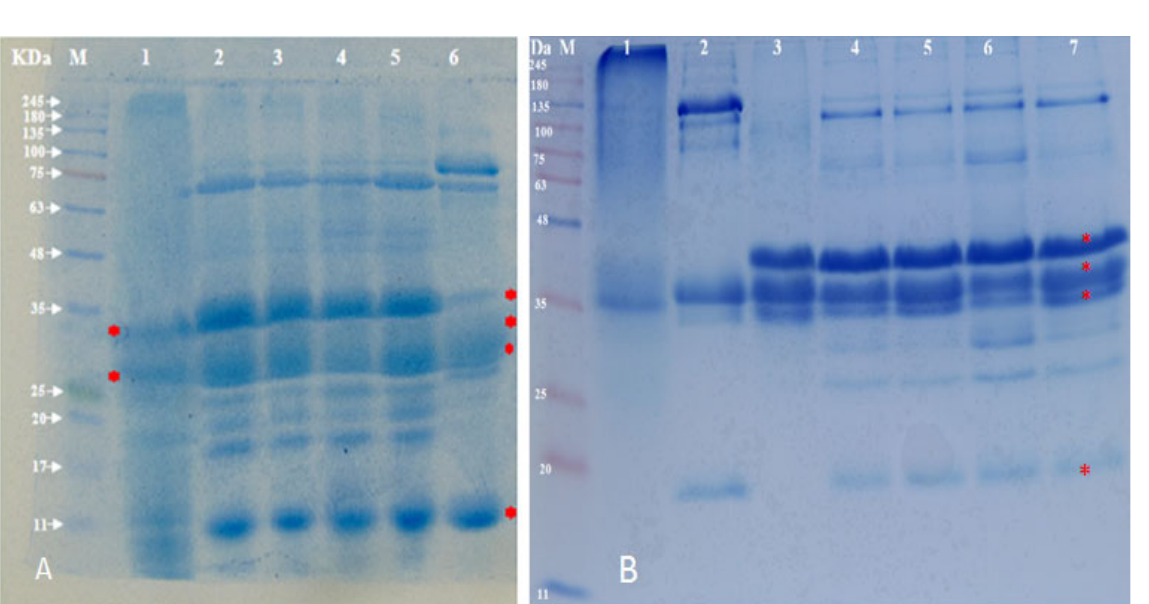
Table 3. Total milk cream and casein (gm) contents (Mean ± SE) in Saudi camel breeds (Safra, Wadha, Hamra, Majahem).